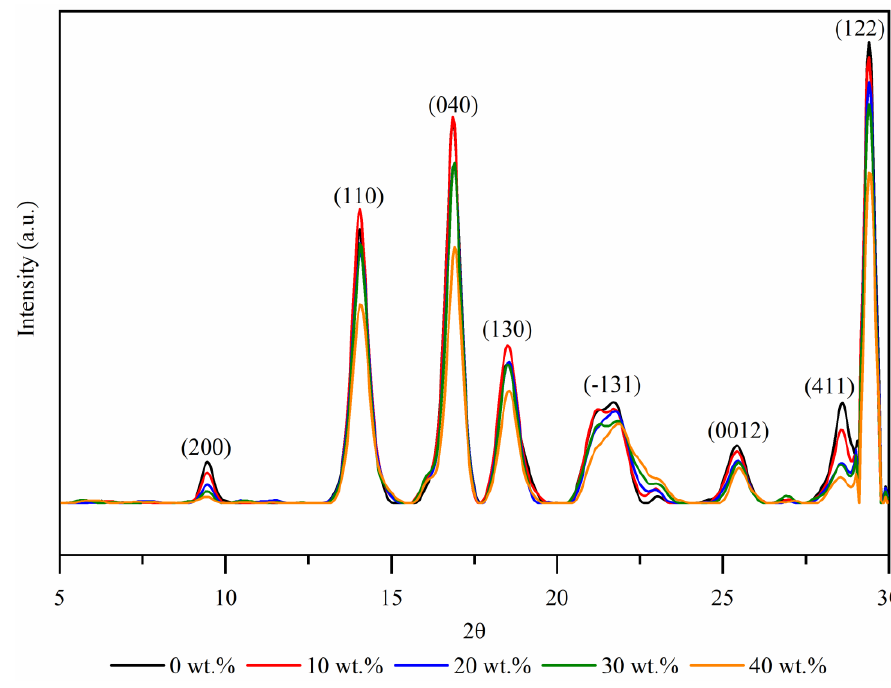
Figure 7. X-ray diffraction (XRD) spectra of the composites with neat (RPP) matrix.